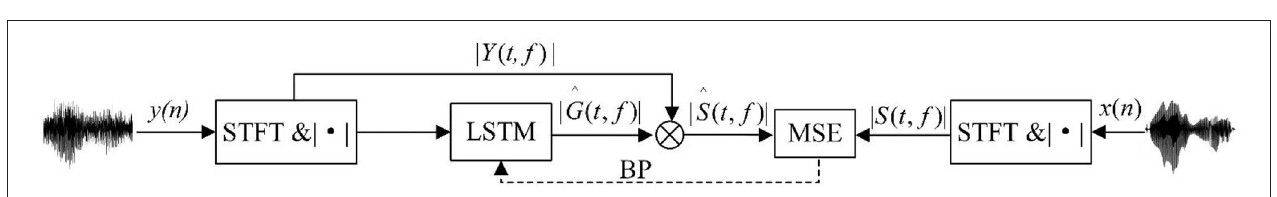
FIGURE 3 | The diagram for training the LSTM with MSE loss.